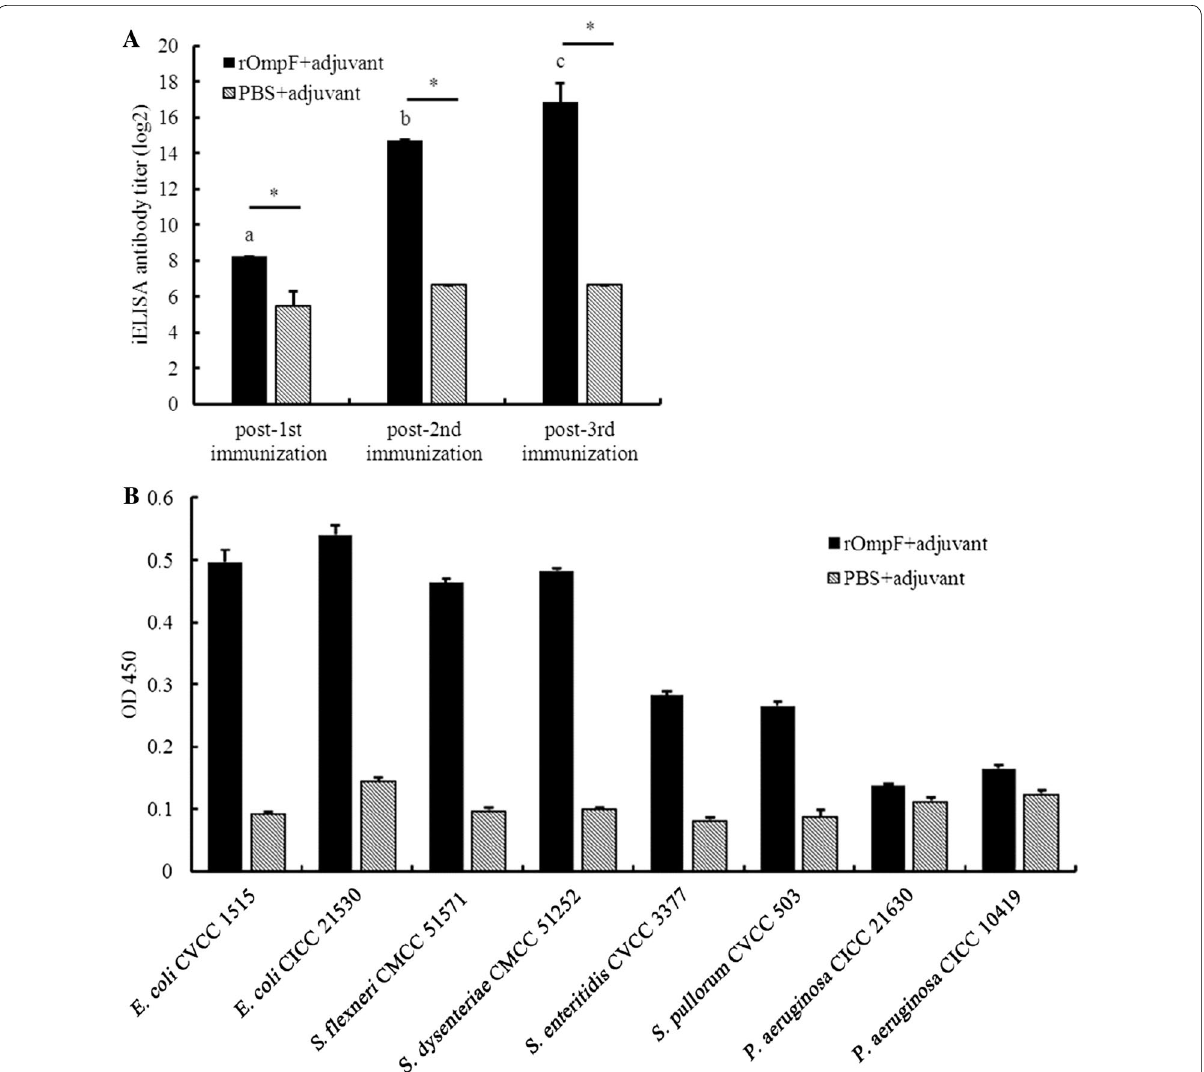
Fig. 4 Serum responses in mice immunized with rOmpF. Mice were immunized with rOmpF at day 0 and boosted at the 3rd-week and 5th-week respectively, and sera were collected at 5-day intervals after each immunization. iELISA was used to detect the antibody titers. Results were shown as mean SD for 10 mice. A Titers of the anti-rOmpF sera against rOmpF. Asterisk indicates a significant difference between the OmpF immunized ± group and the control group ( p < 0.05). Different lower case letters indicate a significant difference between each immunized ( p < 0.05); B cross- reaction properties of the anti-rOmpF sera against E. coli , Shigella , Salmonella and Pseudomonas . Y axis indicates the optical density (OD 450) values of antibody response with different bacteria in